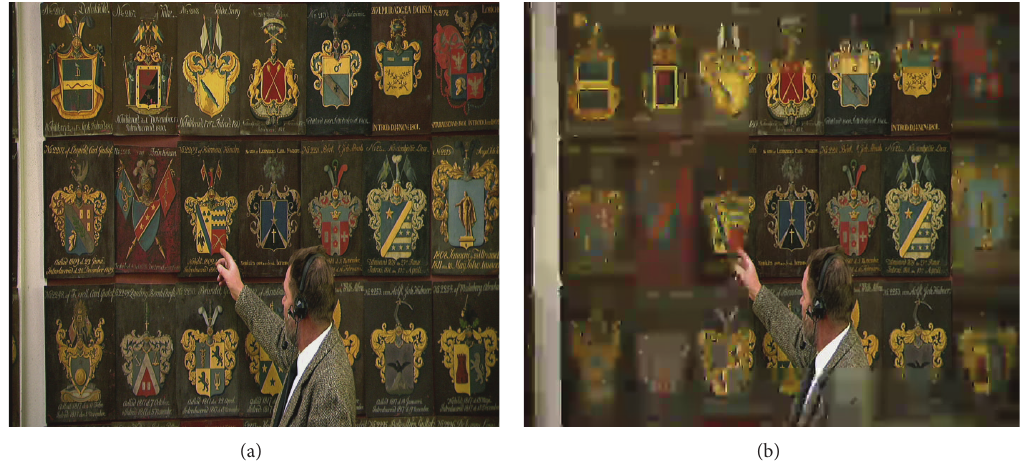
Figure 12: The “SHIELDS” video sequence containing the ROI region, a man’s head and hand pointing to the shields (the quantization parameter of the background region can be determined adaptively); (a) the original frame; and (b) the compressed frame with the higher- quality ROI region. scalability comparison: bit-rate for 3 SVC layers (based on CGS scalability comparison: bit-rate for 3 SVC layers (based on JSVM 9.19 reference software) versus only 2 SVC layers with JSVM 9.19 reference software) versus only 2 SVC layers with